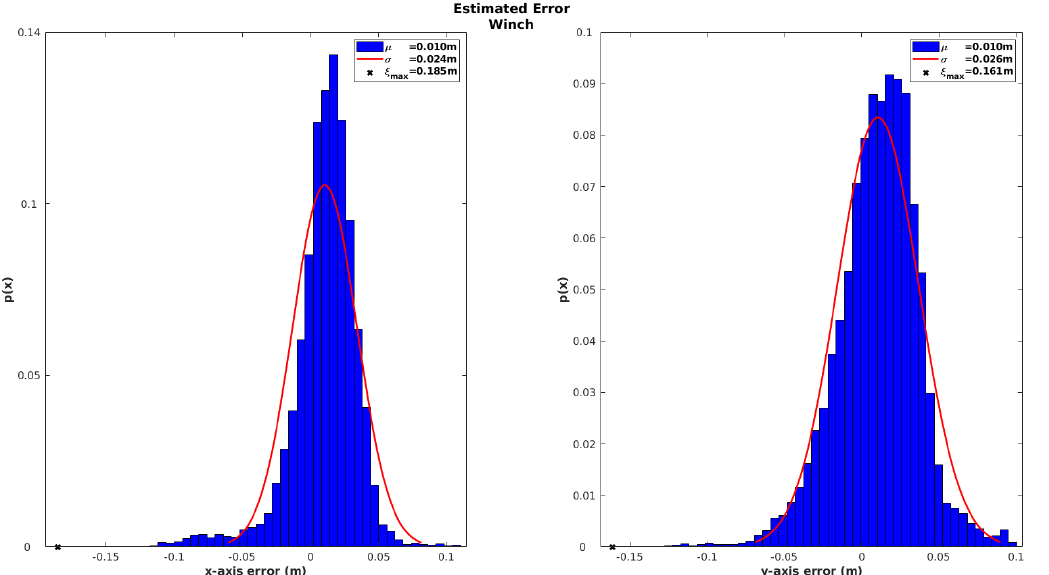
Figure 12. Absolute position error of the SBL range-only model characterized by winch